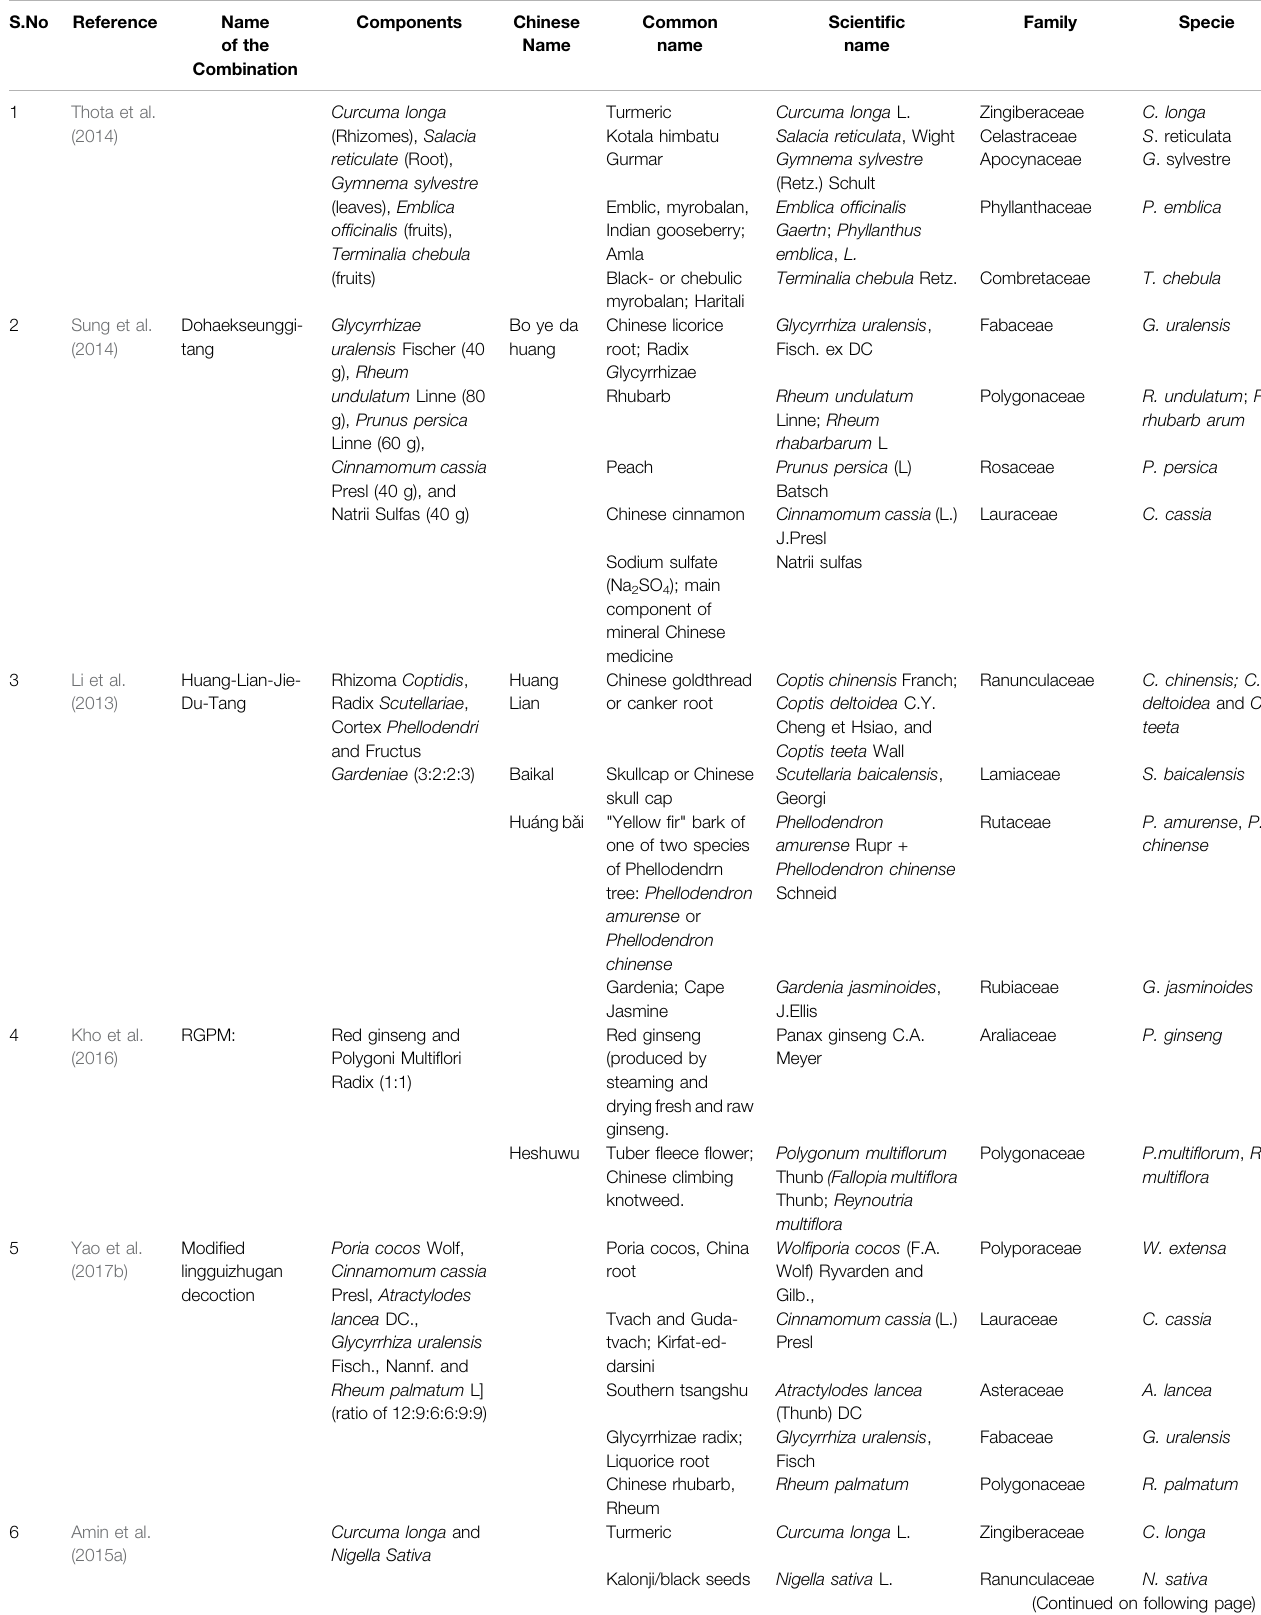
TABLE 1 | Taxonomic classi fi cation of all the polyherbal combinations reviewed in animal Studies. S.No